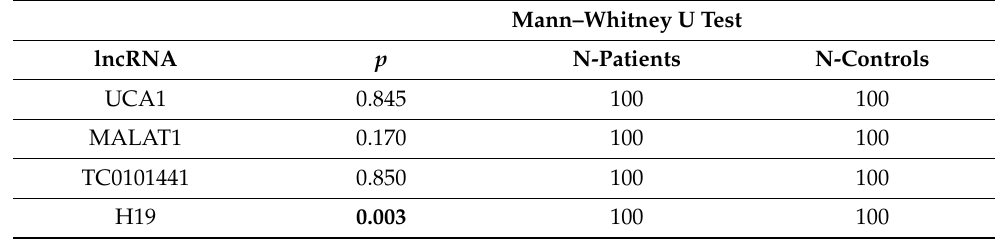
Table 2. Correlation of expressions of lncRNA in patients and controls.